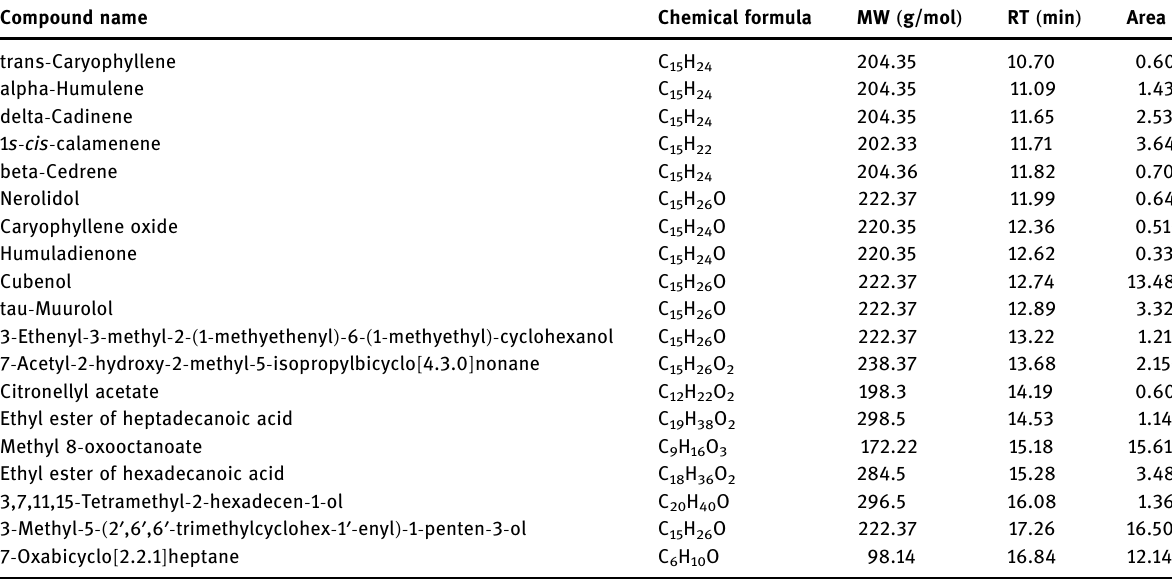
Table 2: GC - MS analysis of